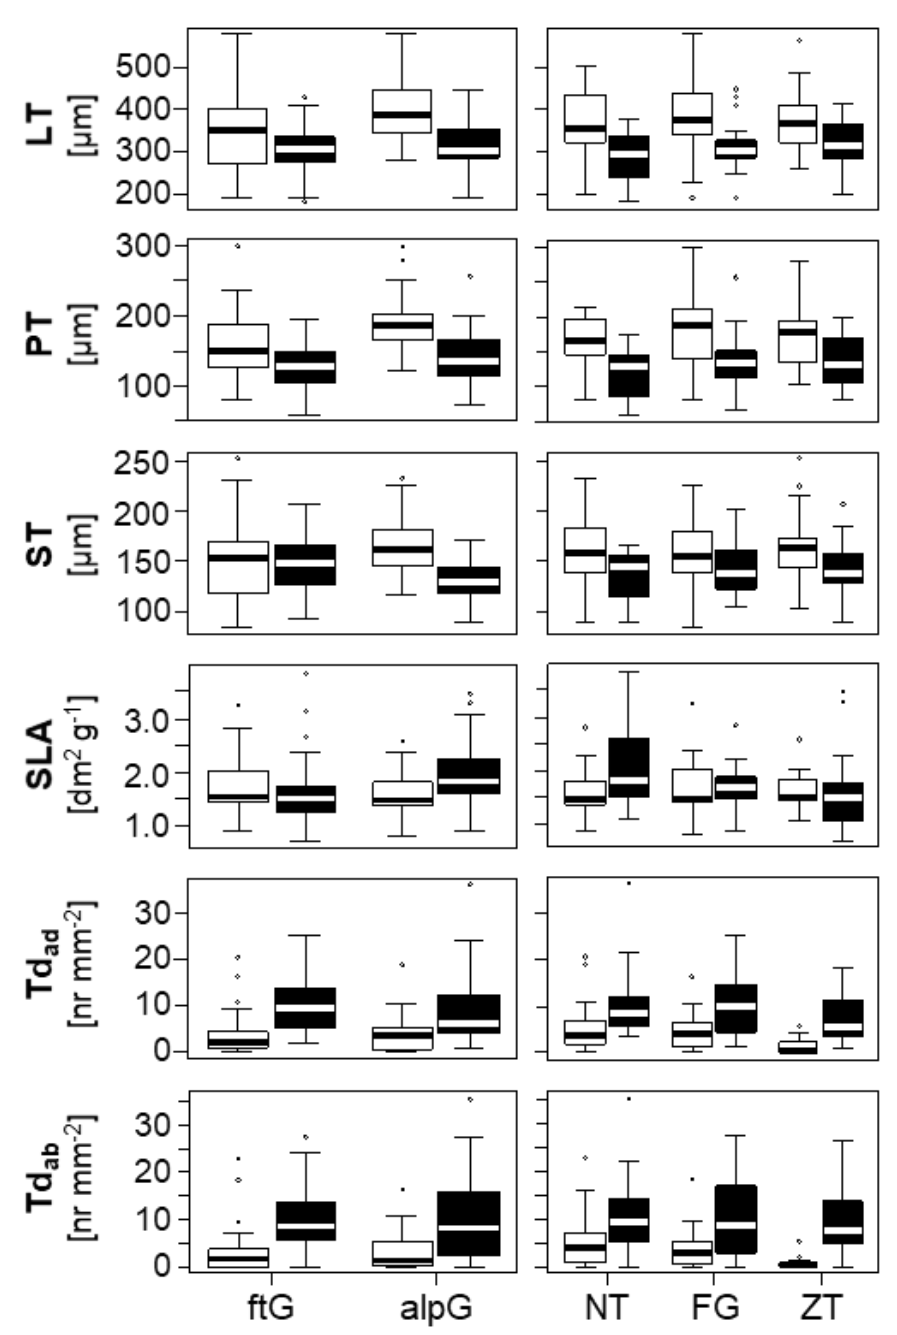
Figure 3. Anatomical traits of leaves of tetraploid A. arenosa populations originating from three mountain ranges, i.e., the Niedere Tauern (NT), the F ă g ă ras mountains (FG) and the Tatra mountains (ZT). Leaf anatomical traits shown are total leaf thickness (LT), palisade parenchyma thickness (PT), spongy parenchyma thickness (ST), specific leaf area (SLA) and trichome density per area on adaxial (TD ad ) and abaxial (TD ab ) leaf surfaces. White and black bars denote alpine and foothill populations, respectively, grown in a foothill (ftG) and an alpine (alpG) common garden. Box plots show medians and the 25th and 75th percentiles, and dots outside 1.5 × interquartile ranges represent outliers. Data for all tetraploid populations per ecotype were pooled; panels in the left row show comparisons between the two different common gardens, and panels in the right row show comparisons across mountain ranges.